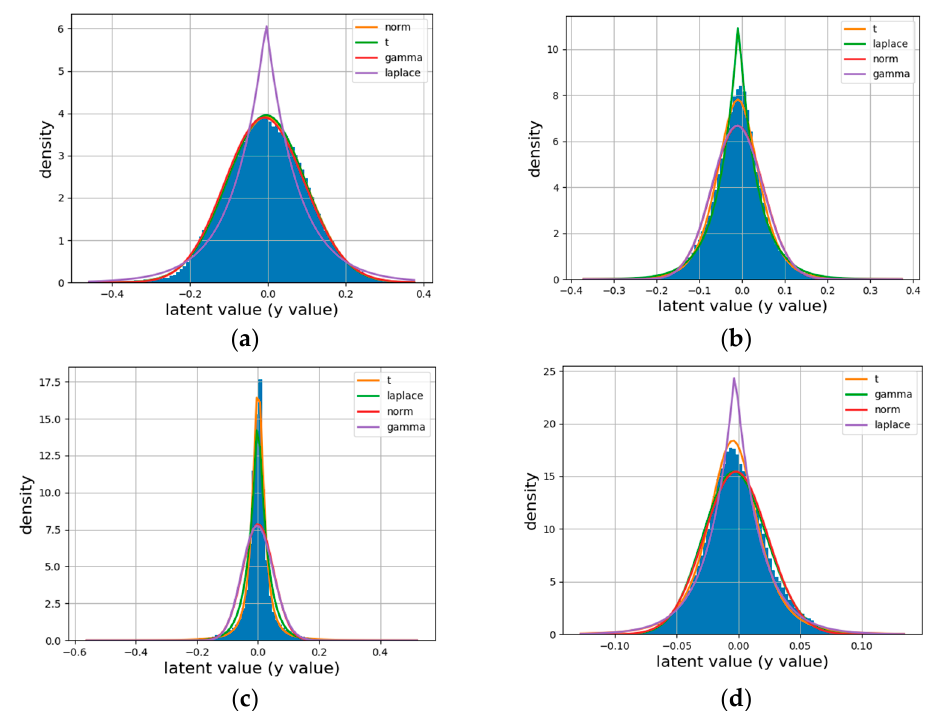
Figure 2. Different distributions (Gaussian (also called norm) and Student’s T (also simplified to t)) fitted to empirical histograms (blue blocks). The best distribution plot is described with the orange line. ( a ) Kodak, ( b ) CAVE, ( c ) KAIST, ( d ) Pavia _ U.